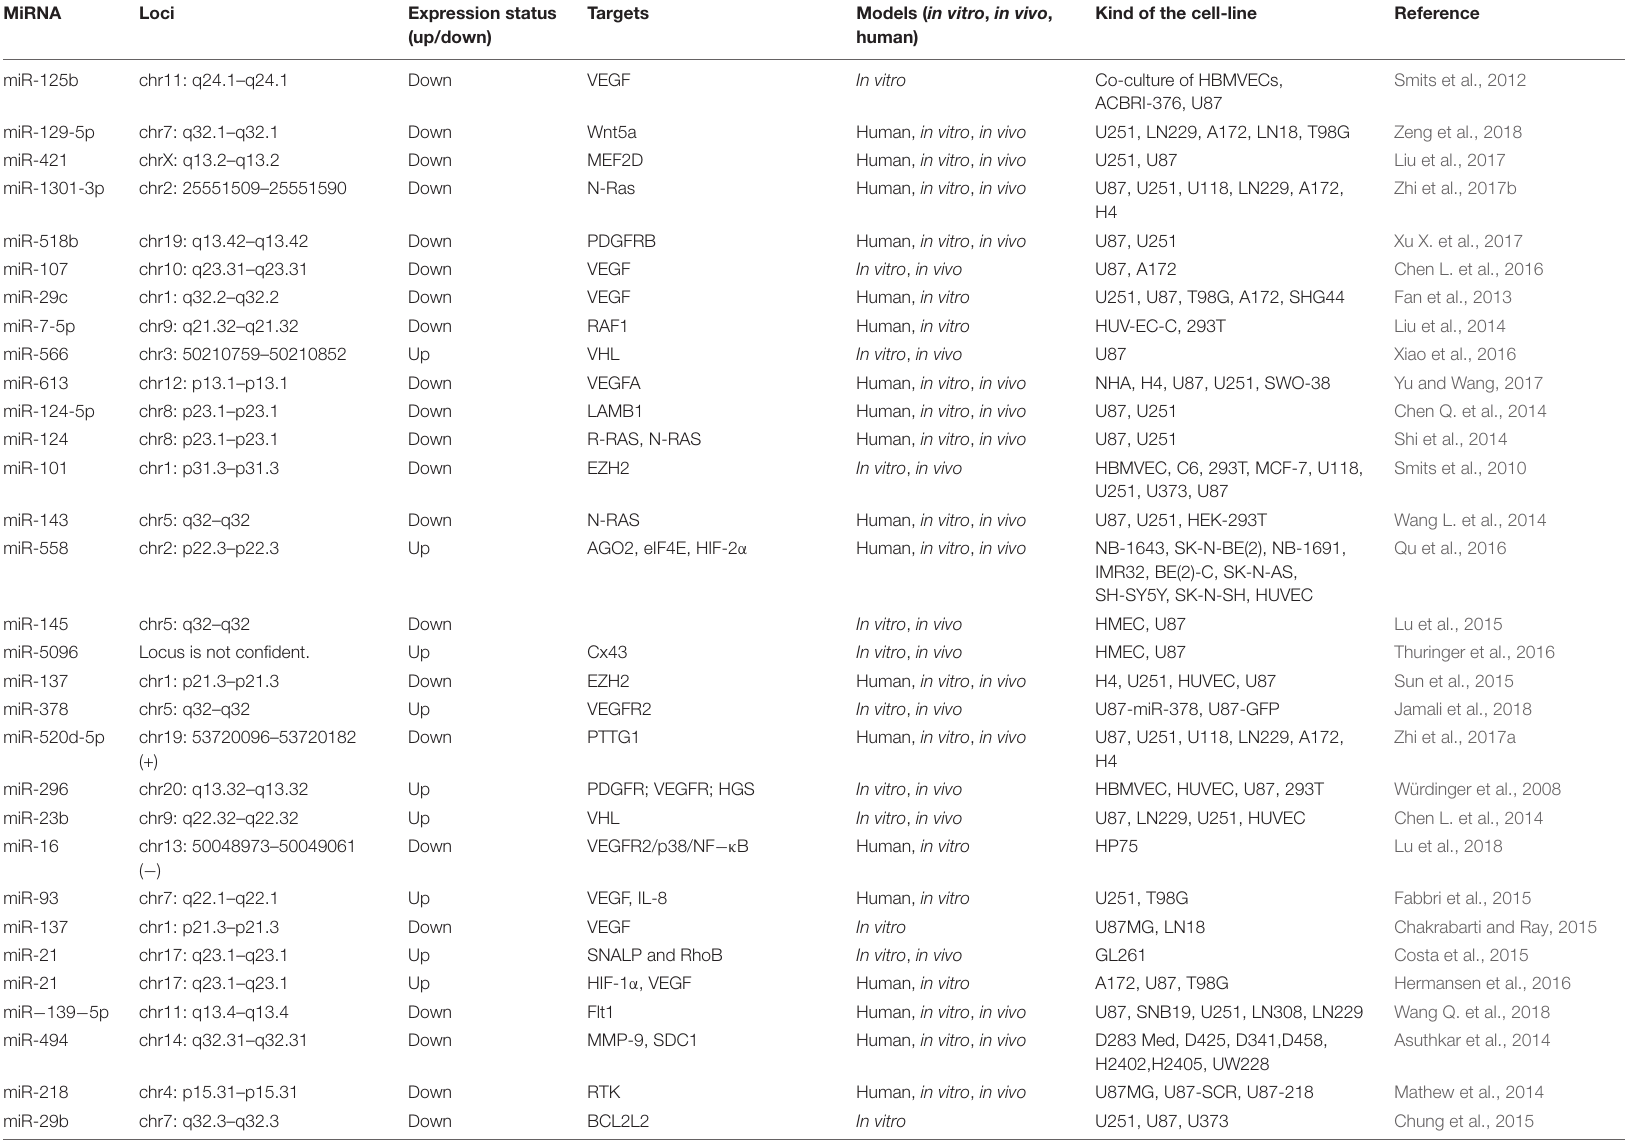
TABLE 1 | Angiogenesis-related miRNAs responsible for GBM. MiRNA Loci Expression status